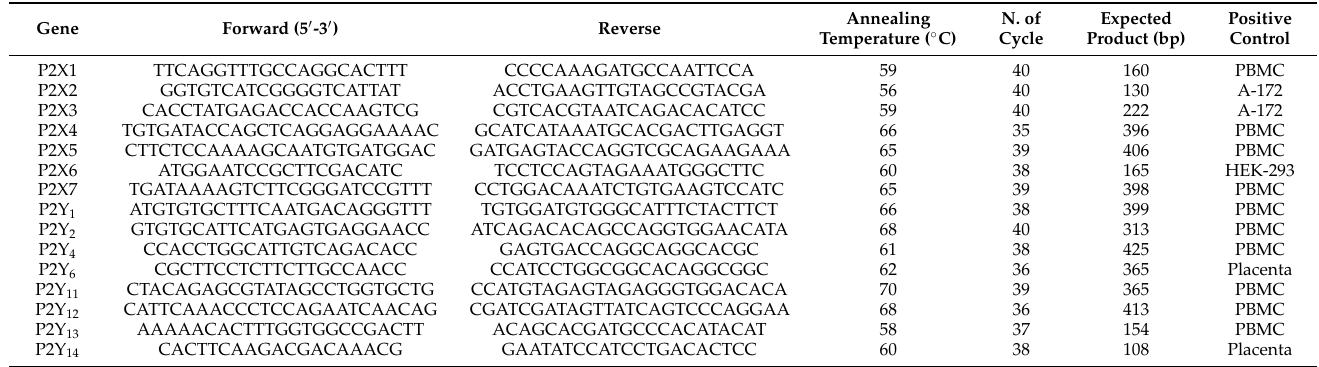
Table 1. List of primer sequences and experimental conditions in